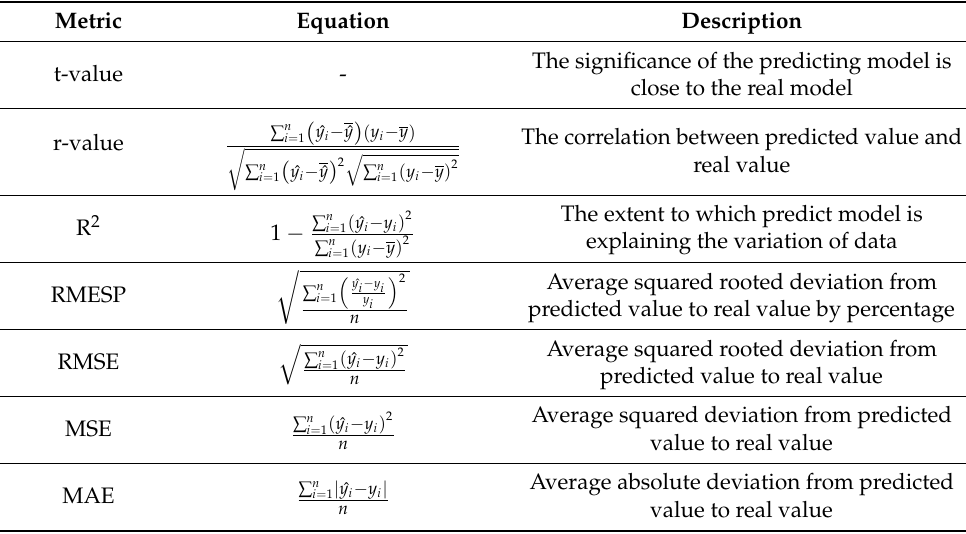
Table 4. Modeling evaluation metric for gas property